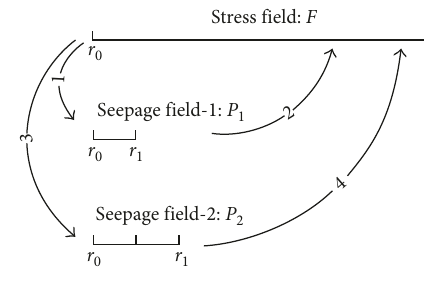
Figure 10: Computation routine.